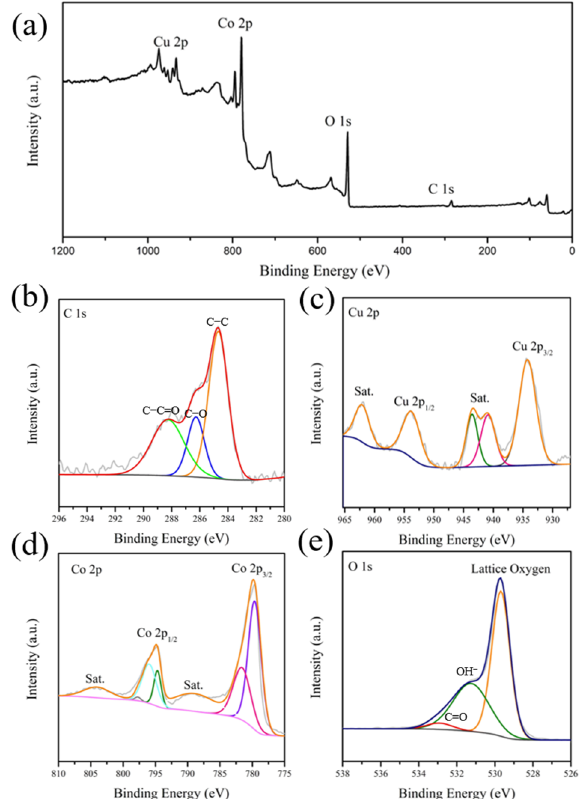
Figure 5. X ‐ ray photoelectron spectra of CuCo 2 O 4 @CNFs, ( a ) survey scan, ( b ) C 1s ( c ) Cu 2p, ( d ) Co 2p, ( e ) O 1s. 2p, ( e ) O